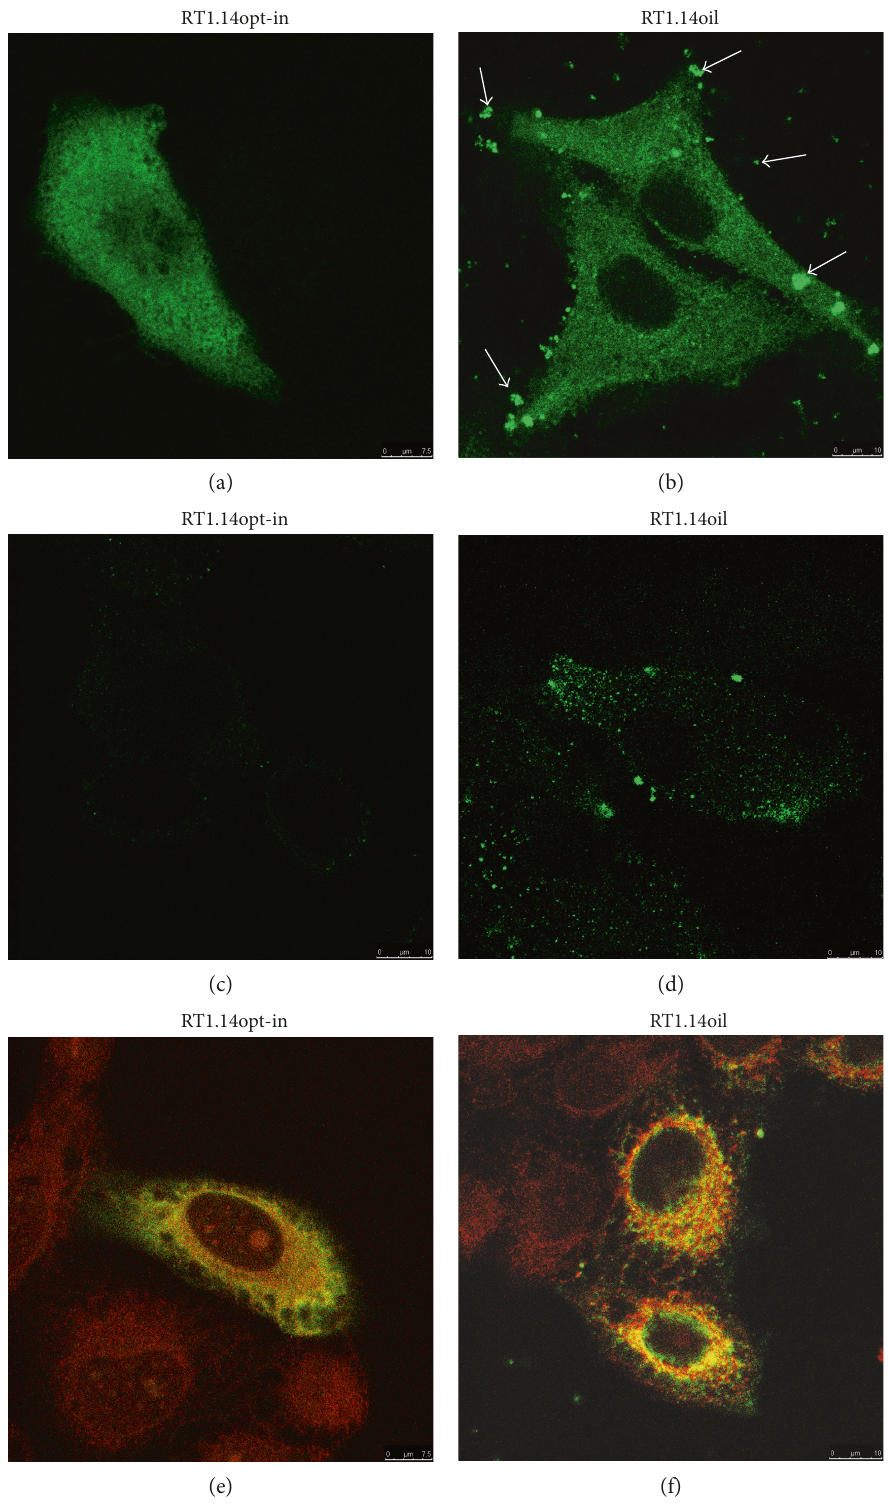
Figure 3: Cellular localization of RT without signal of secretion (RT1.14opt-in) and with a signal peptide (RT1.14oil) in HeLa cells. HeLa cells were transfected with the plasmids pVaxRT1.14opt-in (a, c, e) and pVaxRT1.14oil (b, d, f), grown on slides for 48 hours, fi xed with methanol : acetone (1 :1 v / v ) (a, b, e, f) or 2% paraformaldehyde (c, d), and stained fi rst with polyclonal anti-RT and with secondary FITC-conjugated anti-rabbit antibodies. For localization of RT in relation to ER, HeLa cells were treated with TRITC-conjugated antibodies to an ER marker calreticulin (e, f), and the overlay of FITC and TRITC signals is